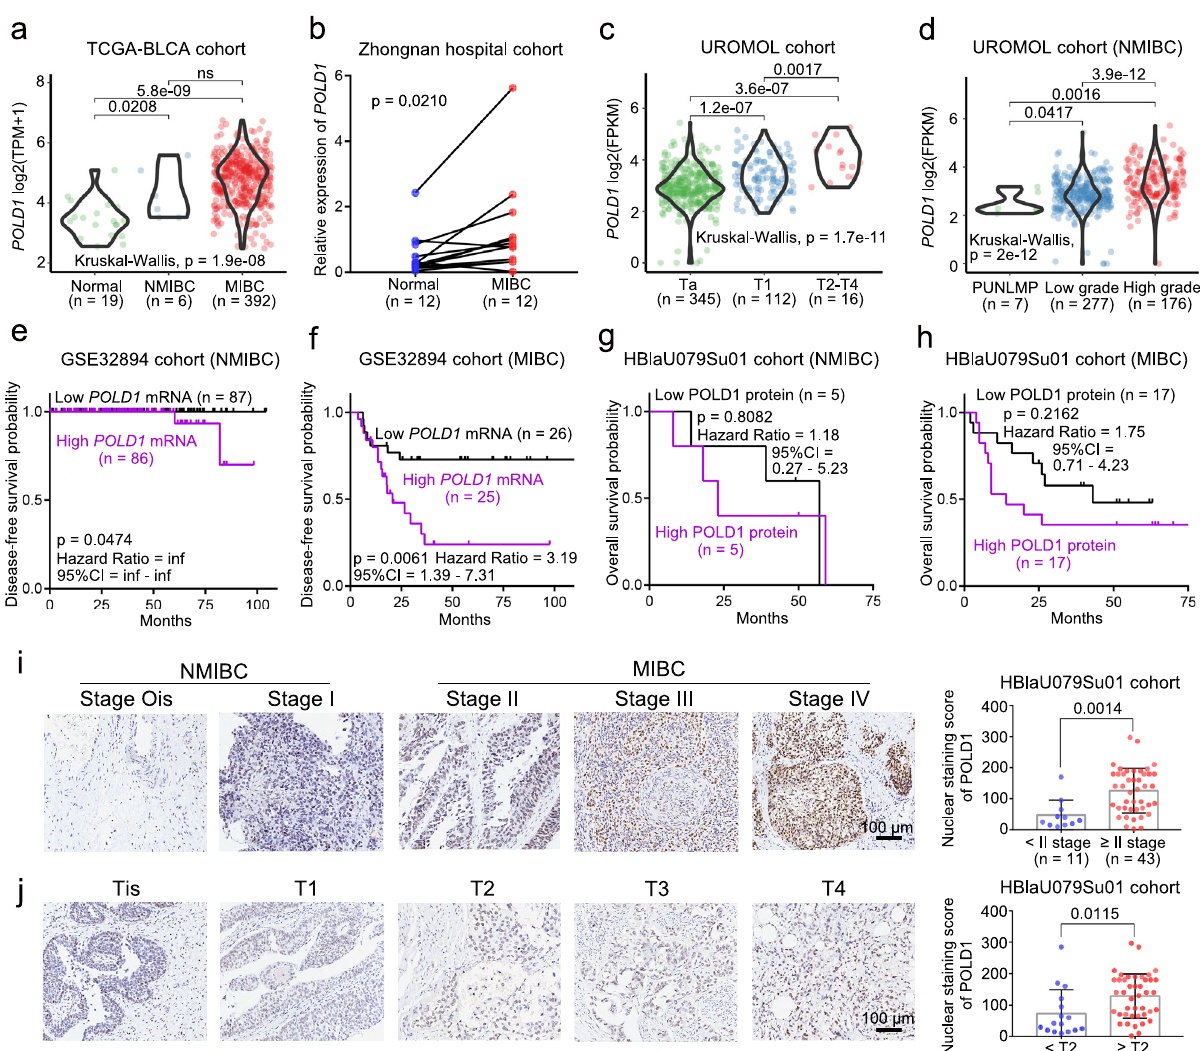
Fig. 1 | Theexpression ofPOLD1 wascorrelatedwith the malignant degreeand prognosis of BLCA. The mRNA level of POLD1 in BLCA (MIBC or NMIBC) and normal tissues in a TCGA-BLCA (RNA-seq data) and b Zhongnan Hospital cohort (RT-qPCR data). Statistical signi fi cance was determined by two-tailed Wilcoxon rank-sum test ( a ) and paired two-tailed Student ’ s T -test ( b ). The mRNA level of POLD1 indifferent c stages(Ta,T1,T2,T3,andT4)and d pathologygrades:Papillary Urothelial Neoplasms of Low Malignant Potential (PUNLMP), low grade and high grade in the UROMOL 39 cohort. Statistical signi fi cance was determined by two- tailed Wilcoxon rank-sum test and Kruskal – Wallis test ( c , d ). The prognostic curve (disease-free survival) of different POLD1 mRNA levels in the two subtypes of e NMIBC and f MIBC in the GSE32894 40 cohort was analyzed. The patients were divided into a high POLD1 mRNA level group and a low POLD1 mRNA level group accordingtothemedian POLD1 expression.Theprognosticcurve(overallsurvival) ofdifferentPOLD1proteinlevelsinthetwosubtypesof g NMIBCand h MIBCinthe HBlaU079Su01 cohort was analyzed. The patients were divided into high and low POLD1proteinlevelgroupsaccordingtothemedianPOLD1proteinlevel.Statistical